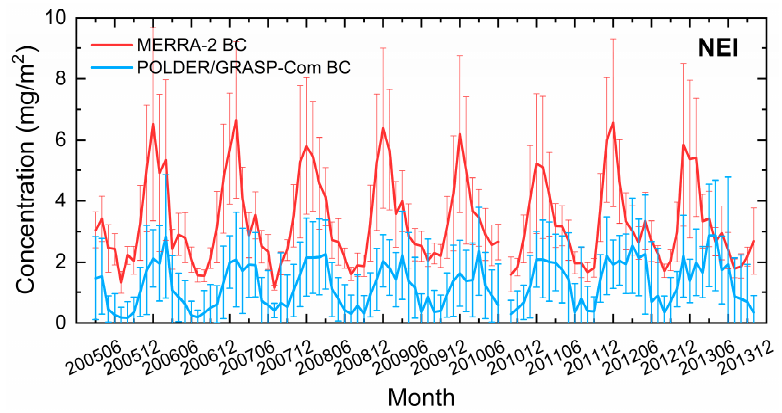
Figure 15. Same as Figure 13, but for Northeast India (NEI)